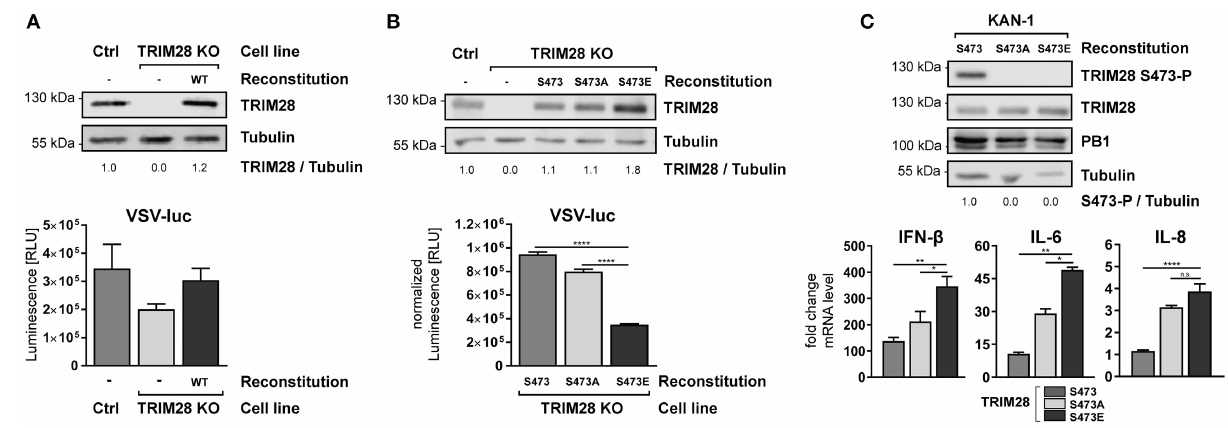
IL-8. Based on our results we hypothesize that TRIM28 is a key determinant for IFN- β overexpression and cytokine-mediated tissue damage and may represent a potential therapeutic target for the treatment of HPAIV-induced hypercytokinemia in